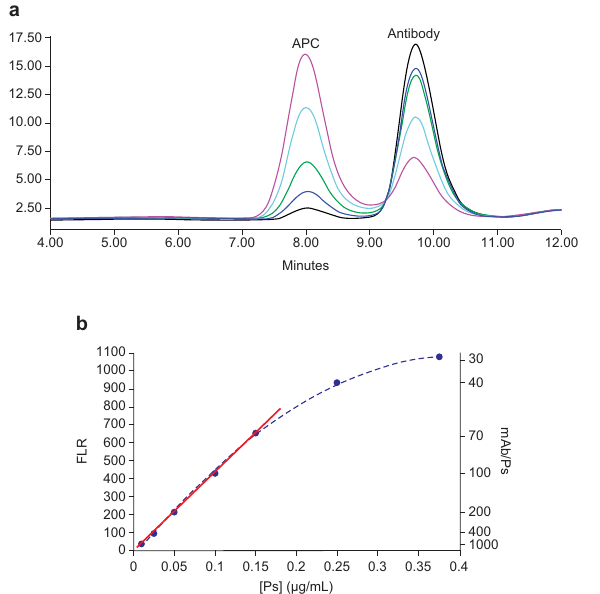
Fig. 6 Antibody titration of ST4 polysaccharide. a Chromatogram overlay of antibody – polysaccharide complex (APC) formed under fi ve different Ps concentrations. APC is eluted out at ~8 min and is separated from unbound antibody (eluted at ~9.8 min) ( b ). A 7-point polysaccharide antibody titration curve. With same antibody concentration at each point, a linear response was observed when polysaccharide concentration ([Ps]) is ≤ 0.15 µg/mL. The linear line started to bend when polysaccharide concentration increased to above 0.15 µg/mL, where antibody to polysaccharide ratio dropped below what is required to saturate all binding epitopes on the